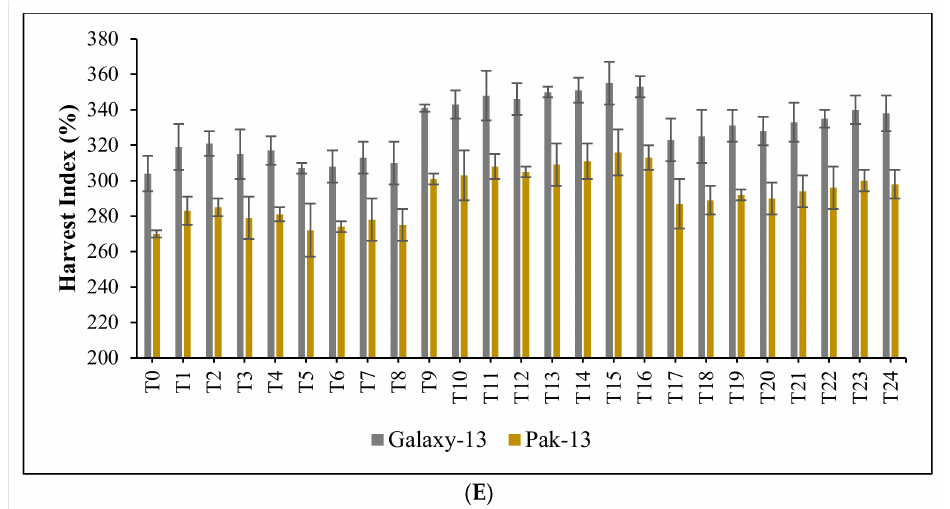
Figure 7. ( A ): effect of phytogenically synthesized bimetallic Ag/ZnO nanomaterials and nitrogen- based fertilizers on the number of grains per pot of both wheat varieties; ( B ): effect of phytogenically synthesized bimetallic Ag/ZnO nanomaterials and nitrogen-based fertilizers on spike length of both wheat varieties; ( C ):effect of phytogenically synthesized bimetallic Ag/ZnO nanomaterials and nitrogen-based fertilizers on 100-grain weight of both wheat varieties; ( D ): effect of phytogenically synthesized bimetallic Ag/ZnO nanomaterials and nitrogen-based fertilizers on grain yield per pot of both wheat varieties; ( E ): effect of phytogenically synthesized bimetallic Ag/ZnO nanomaterials and nitrogen-based fertilizers on harvest index of both wheat